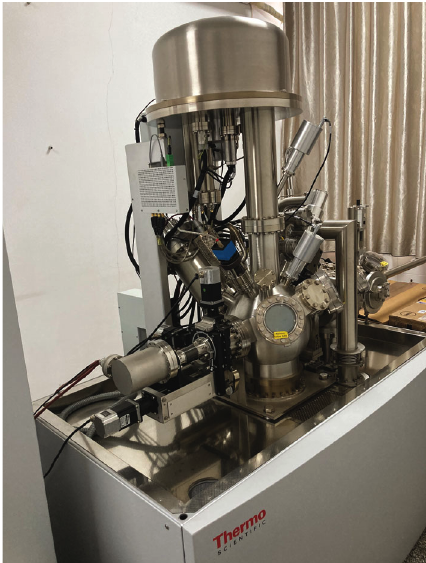
Figure 1: XPS test system.